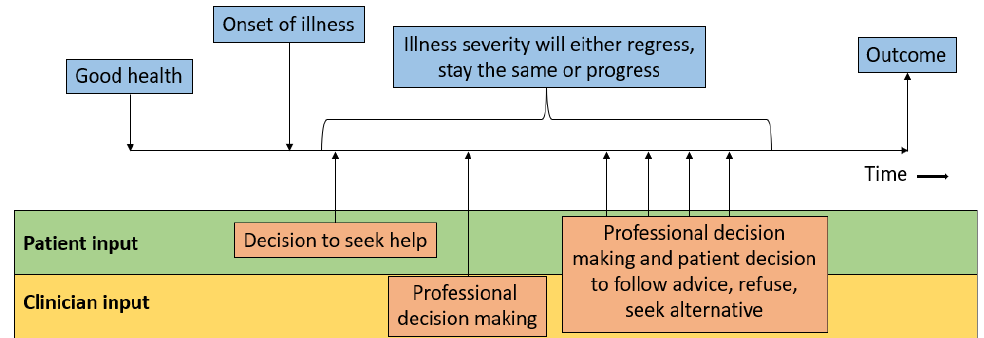
Figure 1. The natural disease